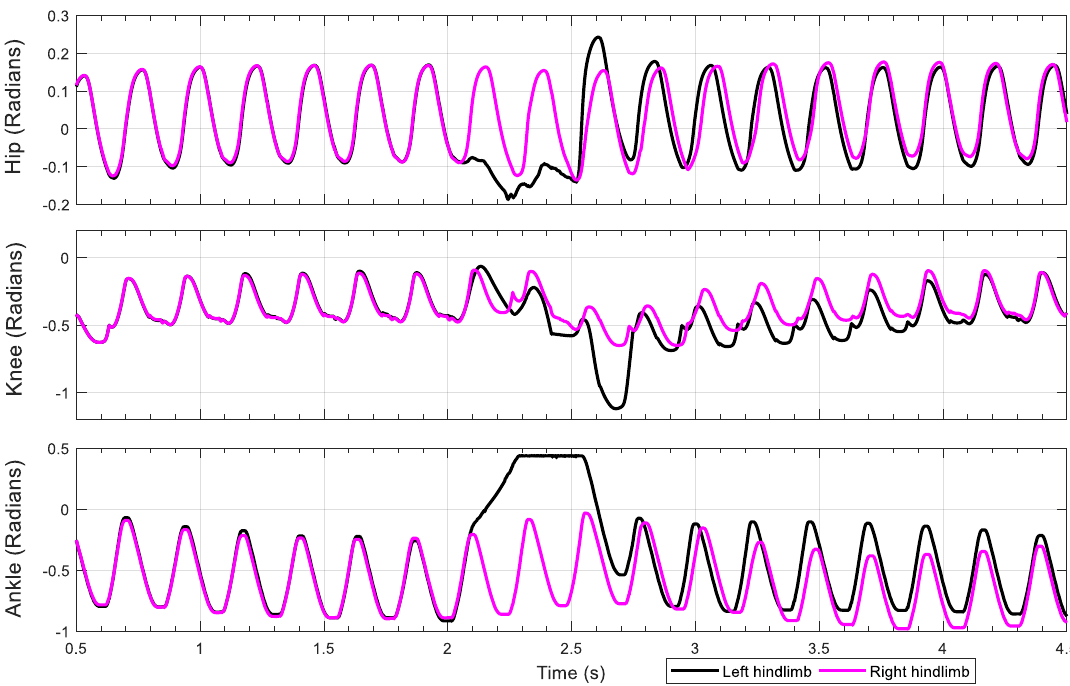
Figure A1. Limb joint motion during a non-resetting experiment. The stimulus is applied to the left hip pattern formation extensor neuron from 2 to 2.5 s with a current of −10 nA.